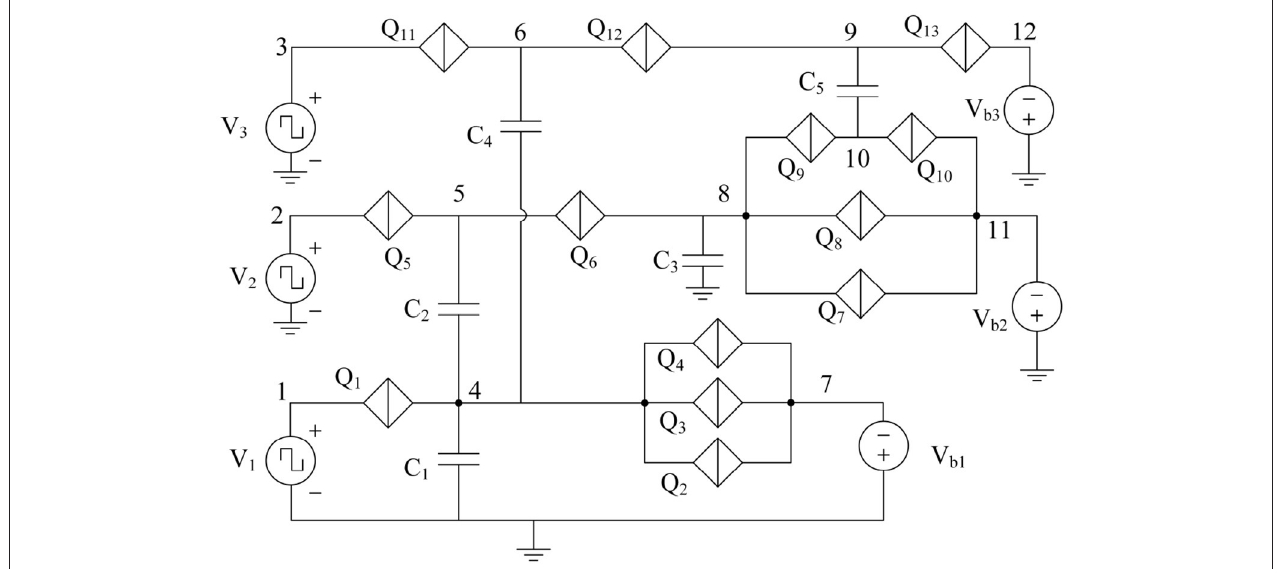
FIGURE 12 | 3 × 3 synapse network with 5 charge island capacitively coupled to each other. Capacitance values are given by: C 1 = 6 fF, C 2 = 3 fF, C 3 = 8 fF, C 4 = 2 fF, and C 5 = 5 fF. Voltage pulse inputs are applied at V 1 , V 2 , and V 3 . Weights are programmed using bias voltages V b1 , V b2 and V b3 .